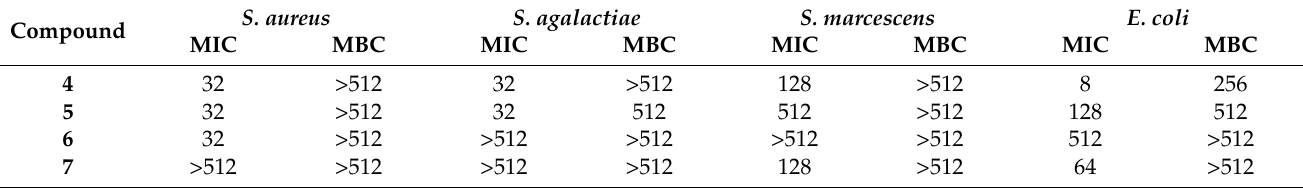
Table 5. Antibacterial activity spectrum of the zwitterionic quinolonates and the quinolone 7 (mg/L).